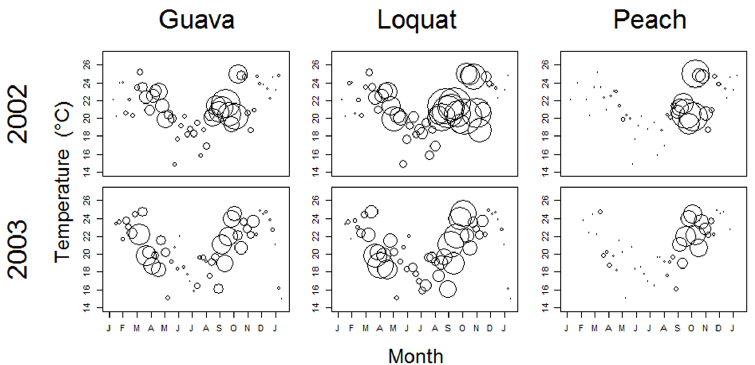
Fig 2. Fruit fly abundance, air temperature (°C), and sampling date for 3 fruit orchards sampled in Monte Alegre do Sul, S ã o Paulo, Brazil in 2002 and 2003. The area of each circle is proportional to the total abundance of fruit flies collected in the sample.